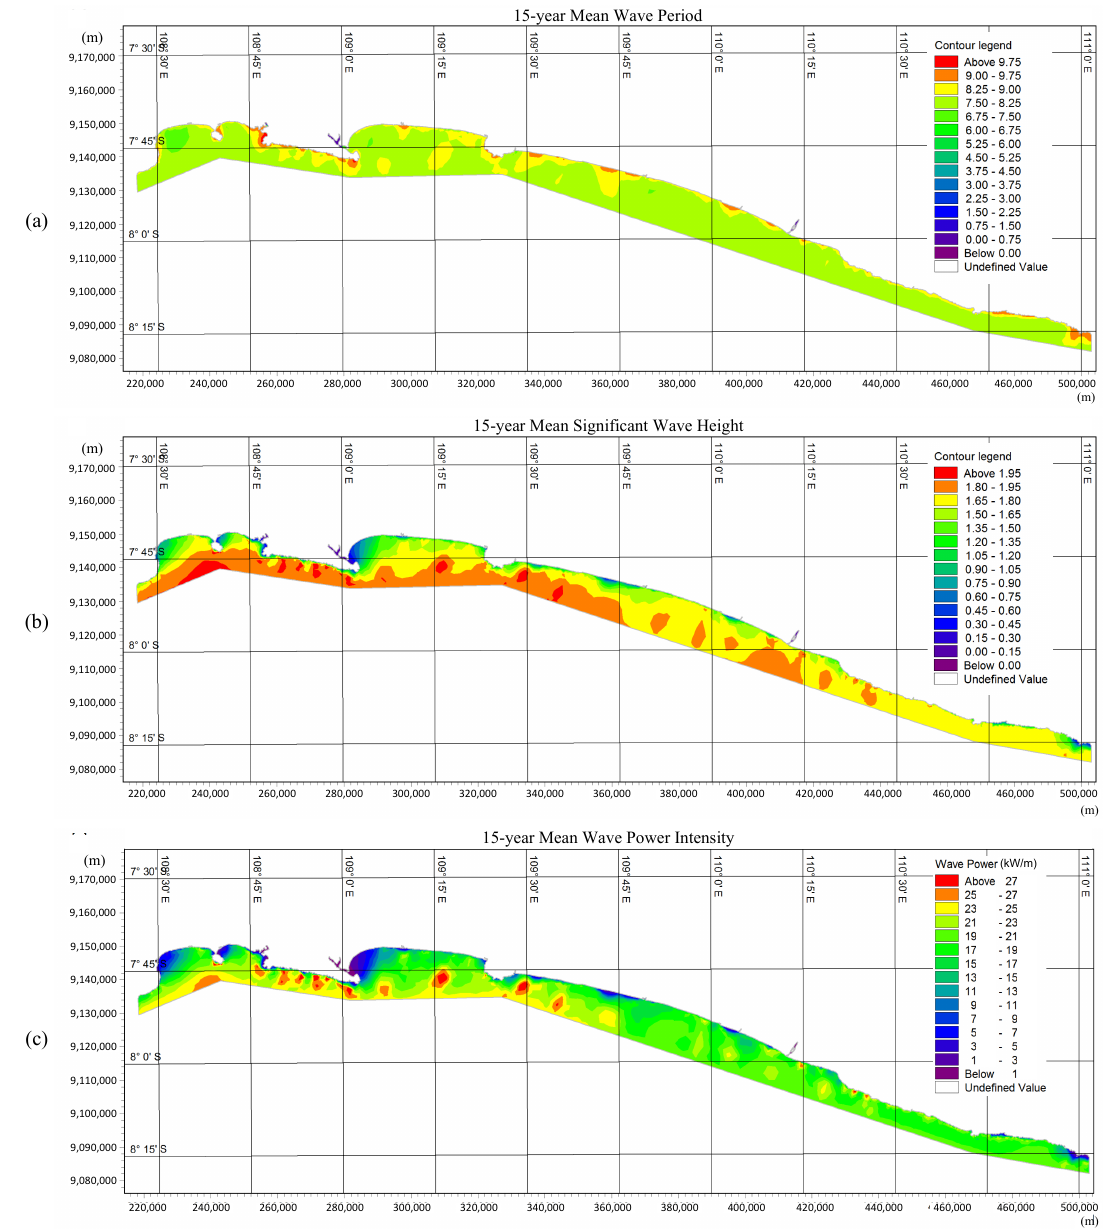
Figure 6. Distribution of the mean wave period ( a ), the mean significant wave height ( b ), and the mean wave power ( c ), for 15-years of